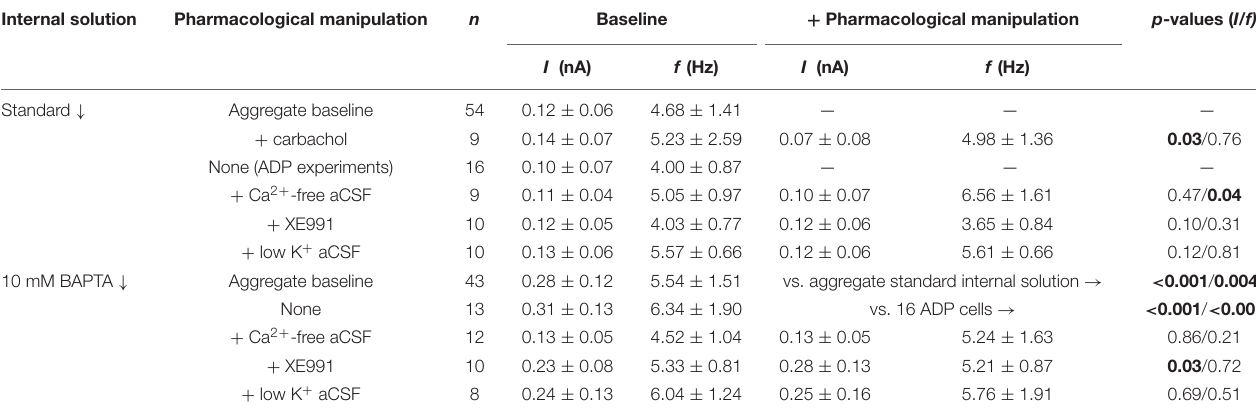
TABLE 2 | Current injections and firing frequencies across experimental